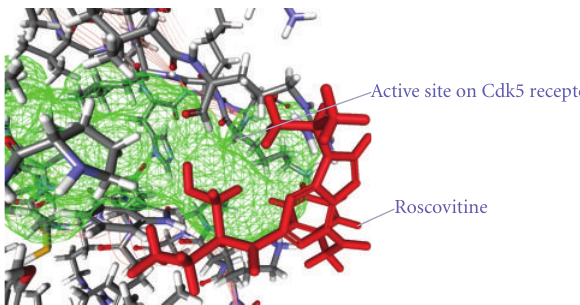
Figure 13: The docked conformation of Roscovitine with the receptor CDK5/p25 (PDB: 3O0G). The Roscovitine is indicated by red color while the most active site of the CDK5 receptor is shown with green